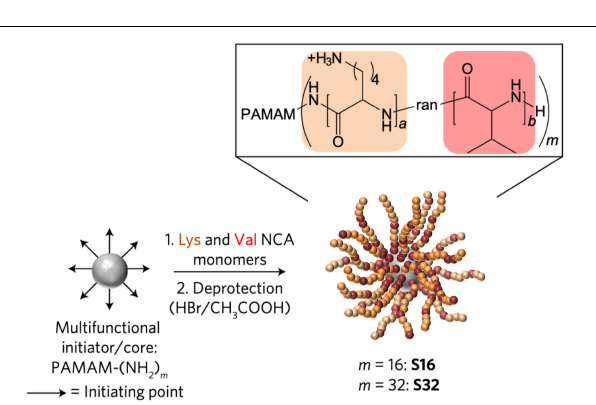
FIGURE 6 | Synthesis of SNAPPs (Lam et al., 2016). Copyright 2016, Macmillan Publishers Limited, part of Springer